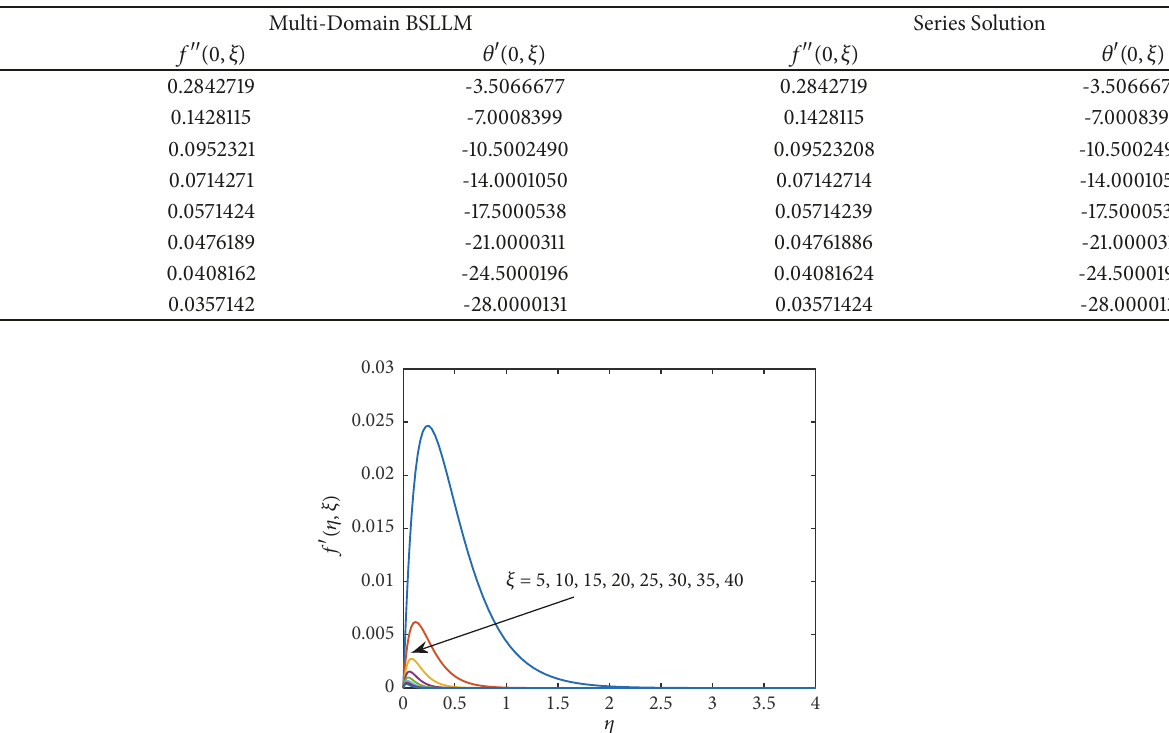
Table 1: Comparison of the MD-BSLLM solution and the series solution for 𝑓 󸀠󸀠 (0,𝜉) and 𝜃 󸀠 (0,𝜉) , with 𝑃𝑟 = 0.7 , 𝑛 = 1/2 , and 𝑧 = 40 .